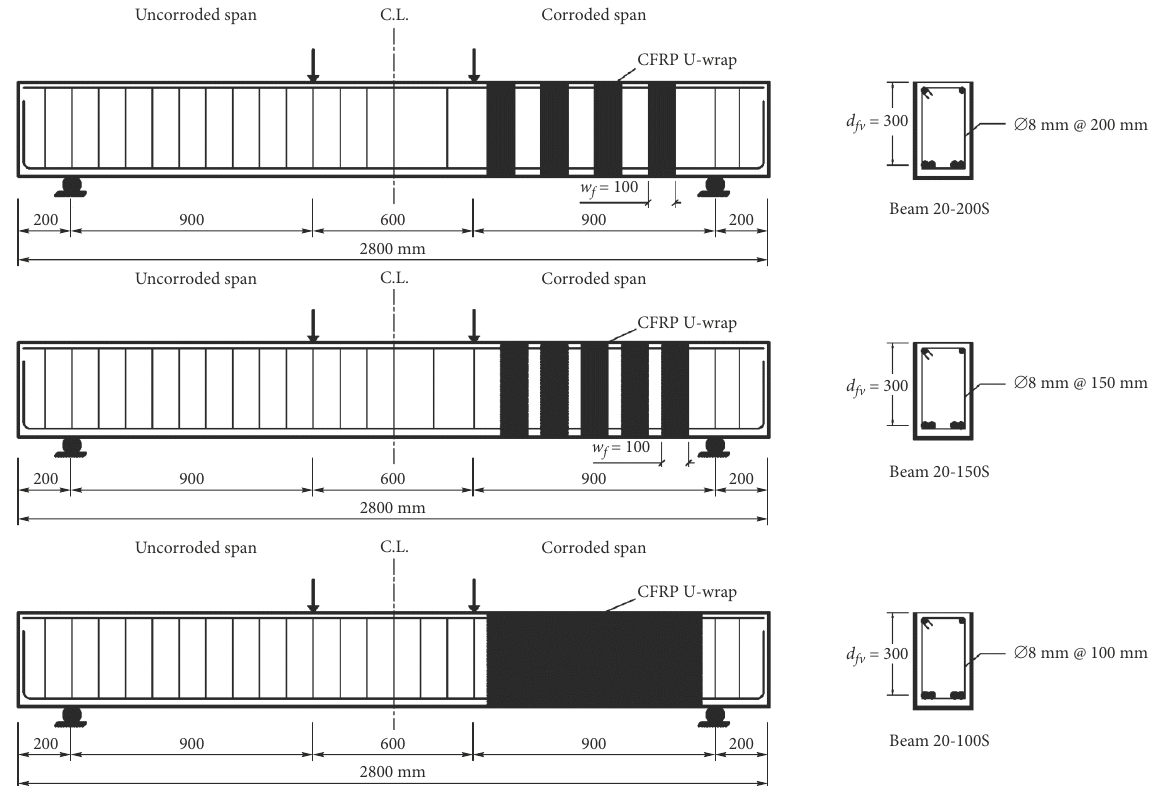
Figure 2. Schematic of CFRP repair of the beams